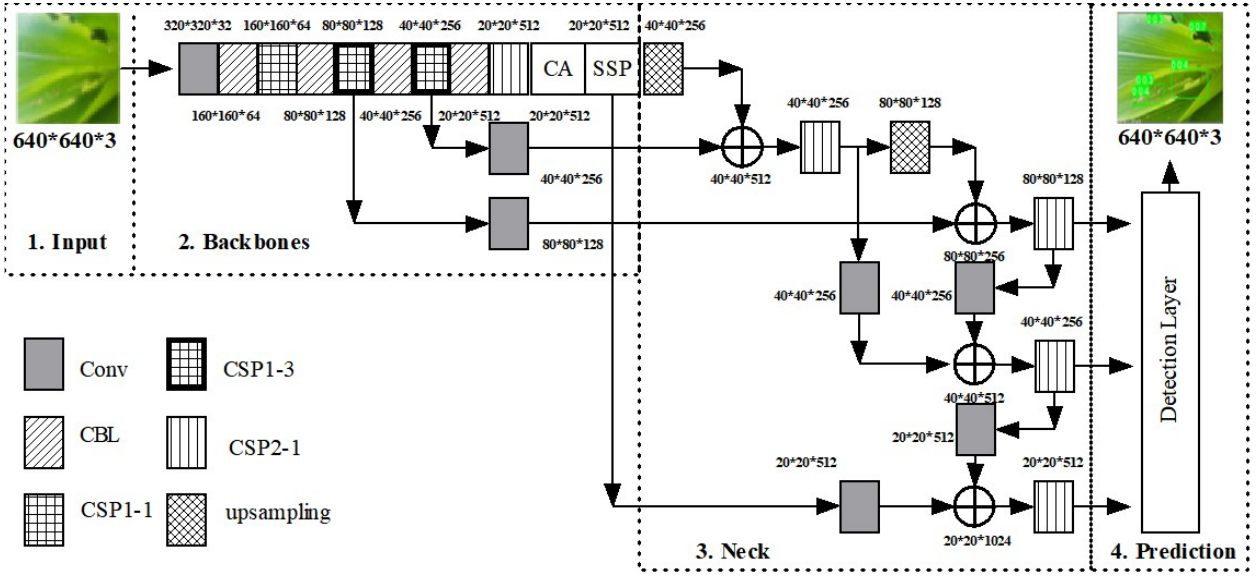
Figure 5. The structure of the one-stage maize leaf detection network based on multi-scale feature fusion.